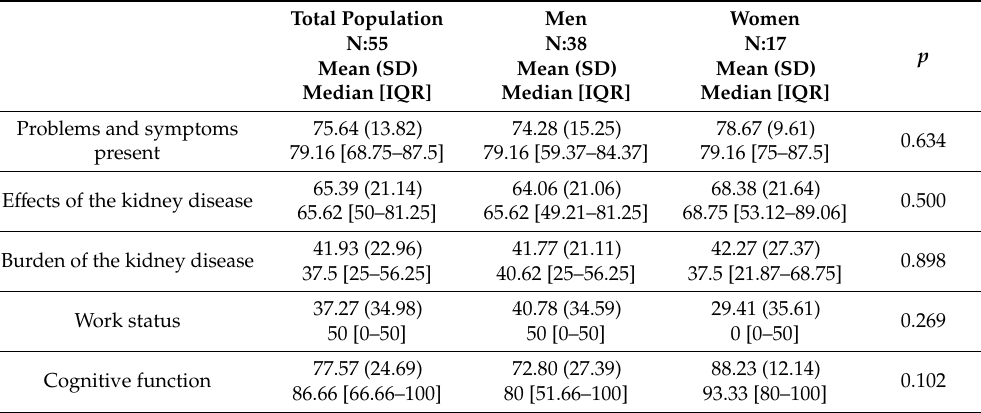
Table 2. Measures of central tendency and dispersion for the Kidney Disease Quality of Life (KDQOL-SF TM )